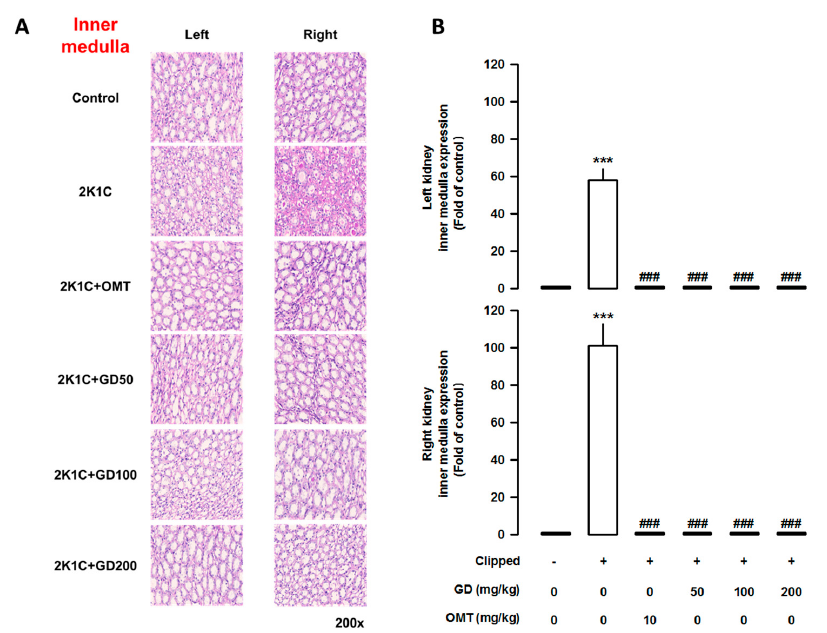
Figure 7. Effect of Gynura divaricata ( L .) DC (GD) on fibrosis in the kidney tissue. ( A ) Periodic acid- Schiff (PAS) staining in the kidney cortex (magnification × 200); ( B ) Quantitative assessments representing the results of five independent experiments. The values are expressed as the mean ± standard error ( n = 5 per group). *** p < 0.001, vs. CONT and # p < 0.05, ### p < 0.0001 vs. 2K1C.